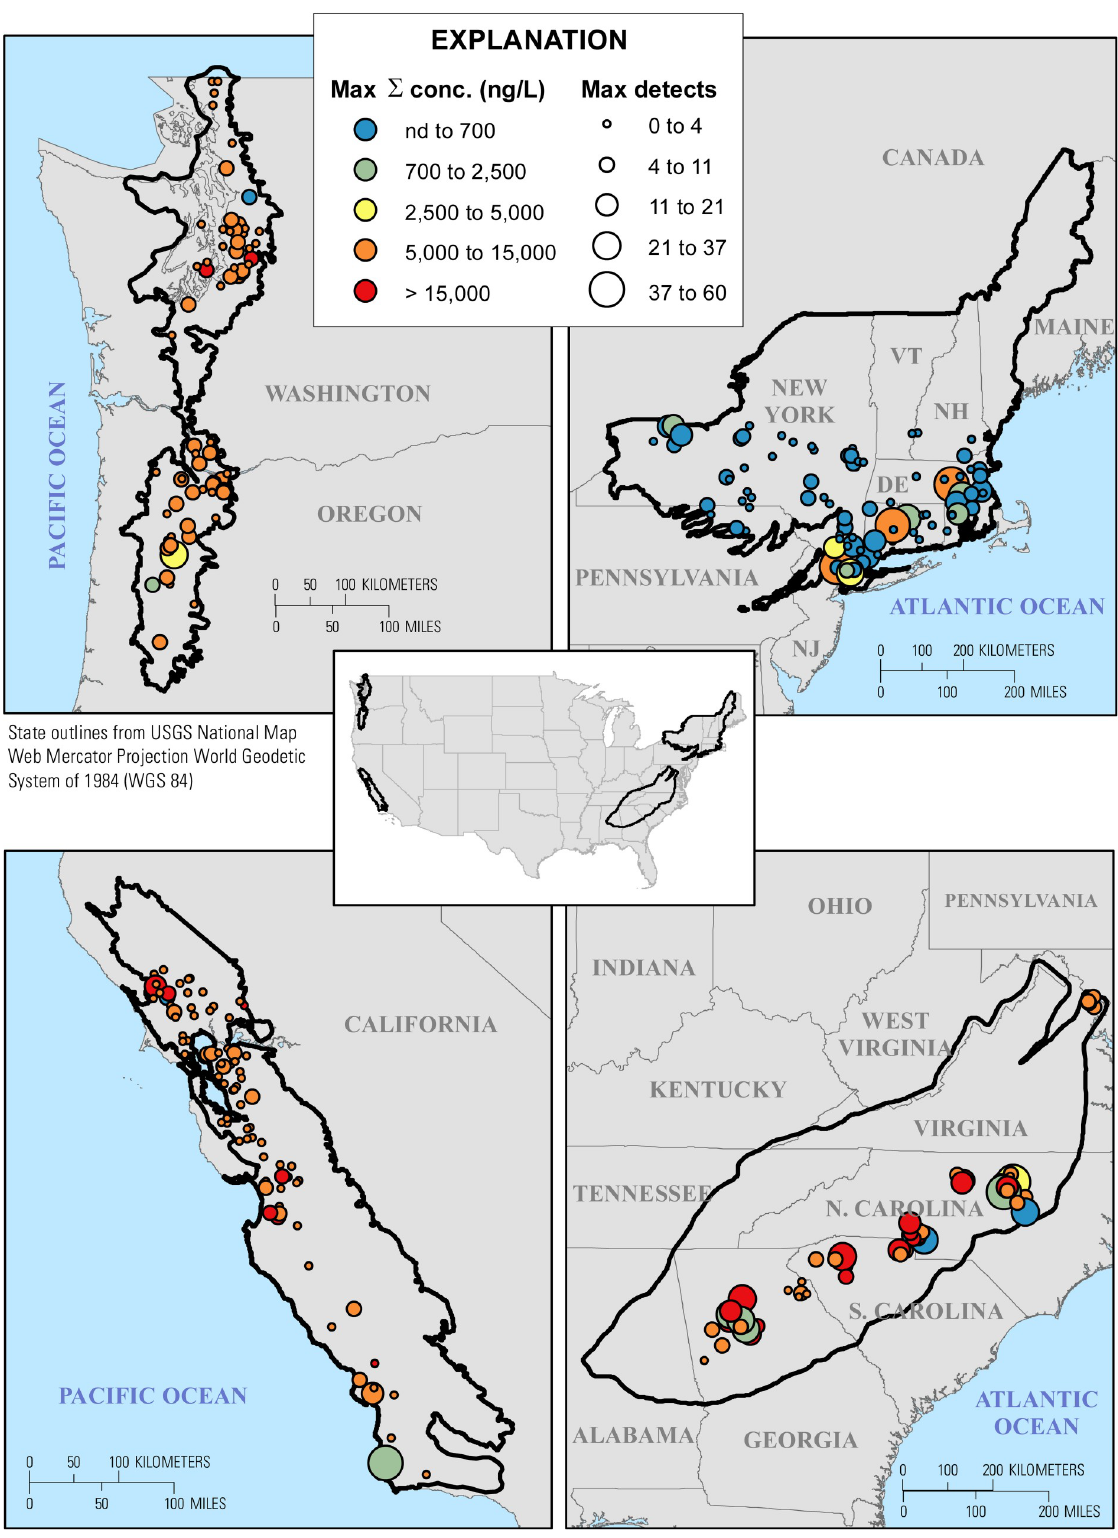
Fig 1. Cumulative maximum concentrations (ng/L) and numbers of pharmaceuticals detected at least once during the 2014–2017 synoptic samplings of water from wadeable streams in the Pacific Northwest (PNSQA, 2015; upper left), Northeast (NESQA, 2016;